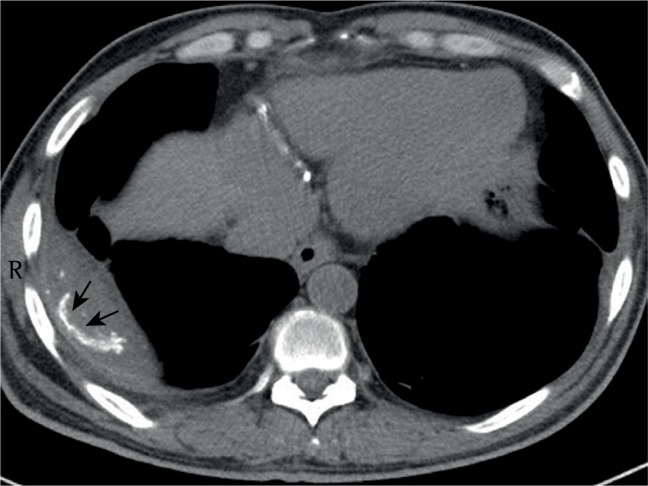
TC de tórax, corte axial, com janela para o mediastino e contraste
intravenoso. Presença de massa (setas) com contorno regular e limites bem
definidos na base do hemitórax direito, exercendo compressão sobre o
fígado e apresentando o típico padrão espongiforme pela presença de gás
no seu interior.